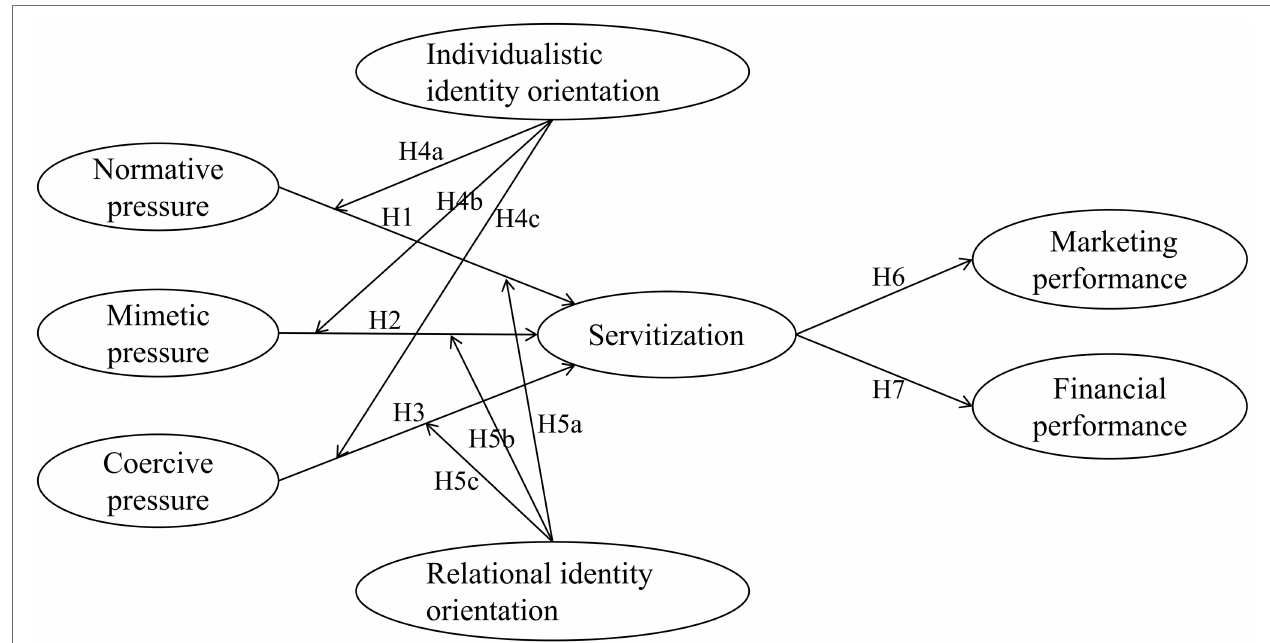
FIGURE 1 | Theoretical models and